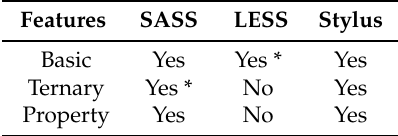
Table 5. Conditional features comparison.